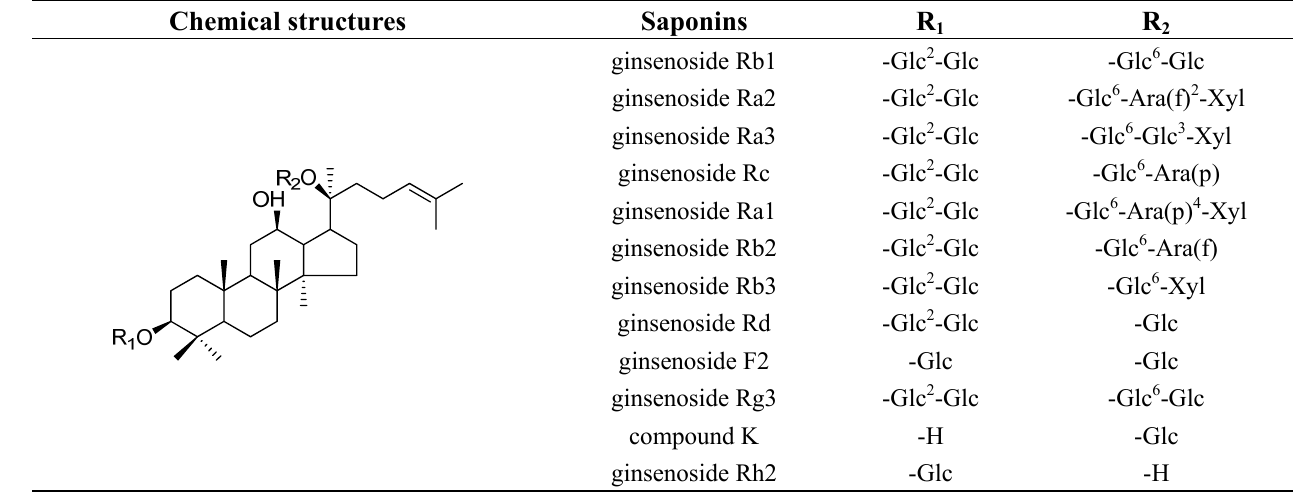
Table 2. Structures of ginsenosides (Glc: β - D -glucopyranosyl, Ara(p): α - L -arabinopyranosyl, Ara(f): α - L -arabinofuranosyl, Rha: α - L -rhamnopyranosyl, Xyl: β - D -xylopyranosyl, glcU: β - D -glucuronic